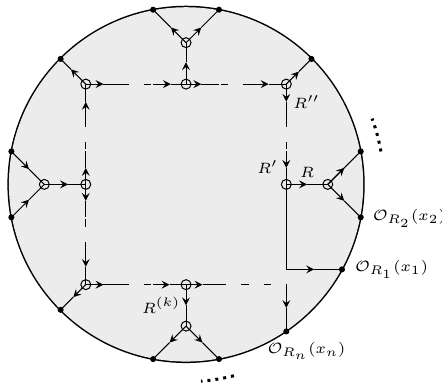
Figure 1 . A typical directed trivalent Open Wilson